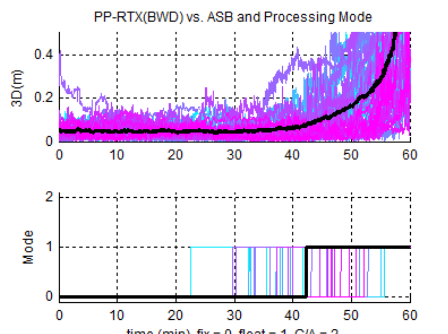
Figure 8: Backward PP-RTX vs. ASB and Processing Mode From the mode plots it can be seen that the average time for the processing mode to indicate the equivalent of fixed ambiguities in the forward and backward passes are 19.7 and 17.7 minutes